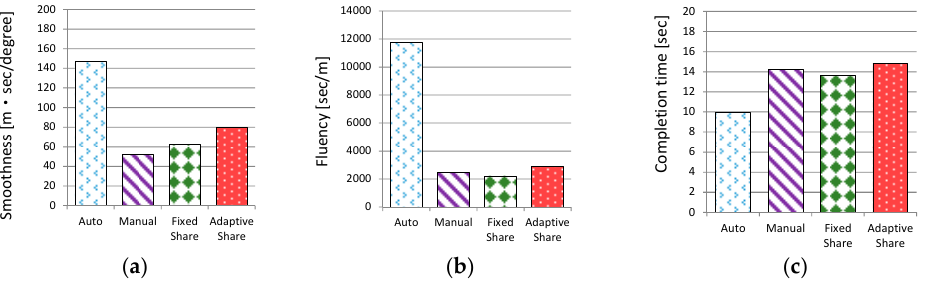
Figure 12. Experimental results of the decision error operation in terms of the three criteria. ( a ) Smoothness ( b ) Fluency, ( c ) Completion time.